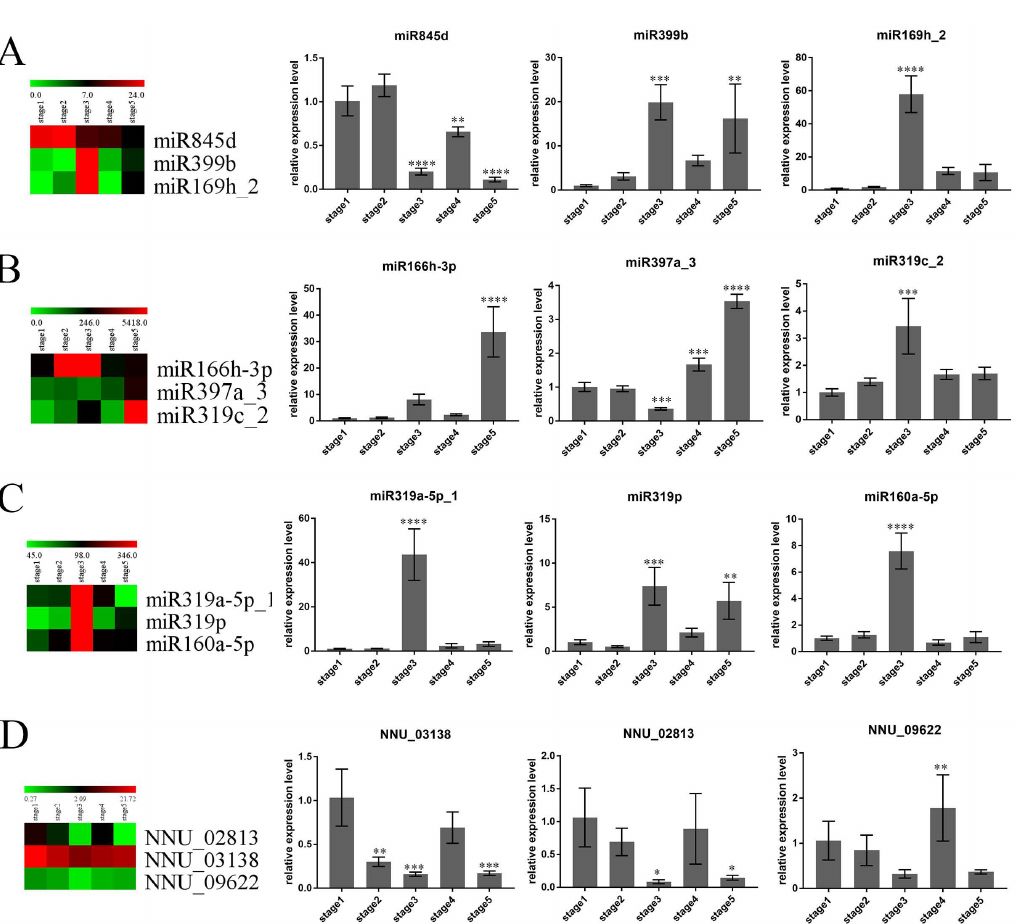
Figure 6. Validation of nine di ff erentially expressed miRNAs and three target genes by qRT-PCR. ( A ) Heatmap and relative expression levels of miR845d, miR399b, and miR169h_2. ( B ) Heatmap and relative expression levels of miR166h_3p, miR397a_3, and miR319c_2. ( C ) Heatmap and relative expression levels of miR319a-5p_1, miR319p, and miR160a-5p. ( D ) Heatmap and relative expression levels of NNU_02813 (the target of miR319p), NNU_03138 (the target of miR319a-5p_1), and NNU_09622 (the target of miR160a-5p). Asterisks indicate a significant di ff erence as determined by one-way ANOVA method between other stages and stage 1. (* p < 0.05; ** p < 0.01; *** p < 0.001; **** p <